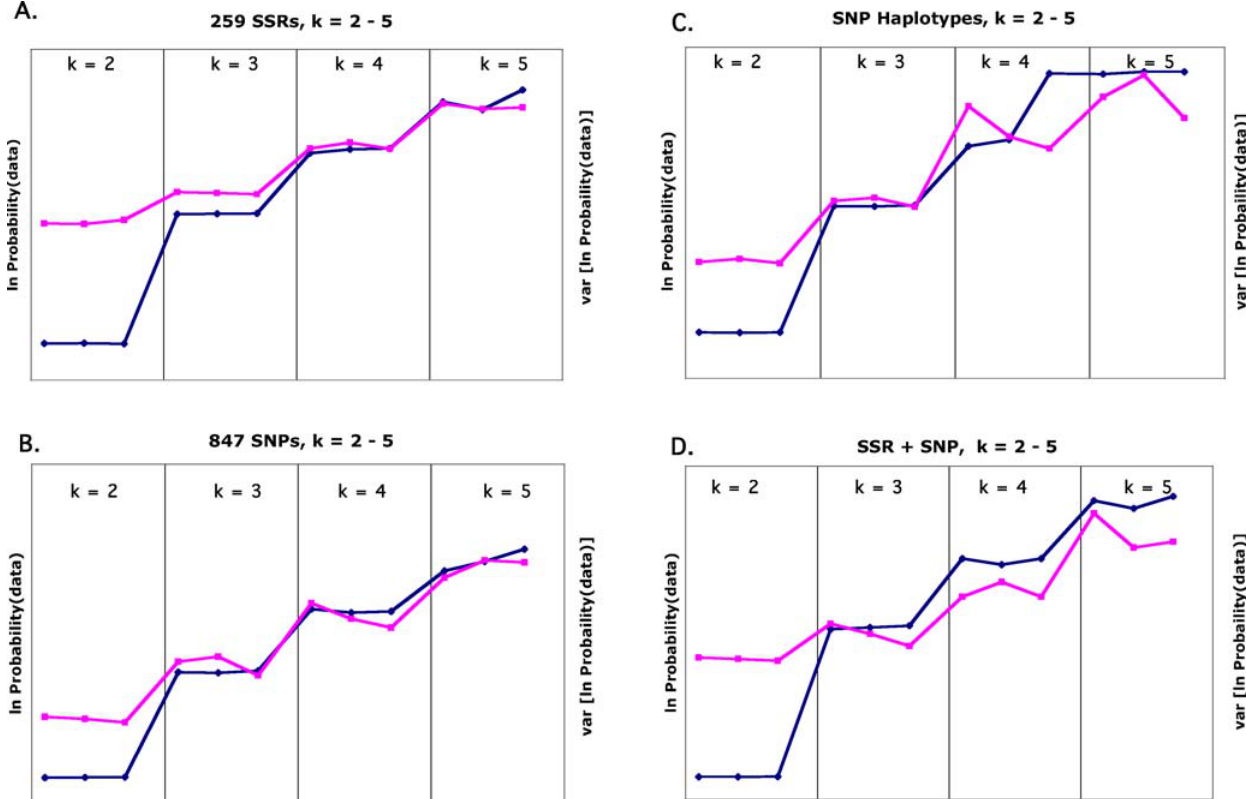
Figure 2. Estimated ln(probability of the data) and Var[ln(probability of the data)] for k from 2 to 5. Values are from STRUCTURE run three times at each value of k, using A) 89 SSRs; B) 847 SNPs; C) 554 SNP haplotypes; D) 89 SSRs + 847 SNPs. The blue diamonds are ln(probability of the data) and the pink squares are var[ln(probability of the data)].